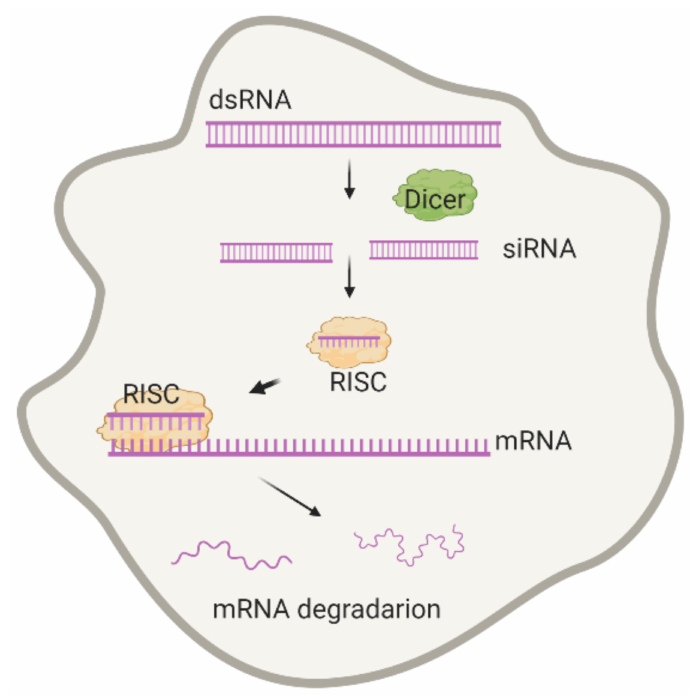
Figure 1. Short scheme of RNAi in